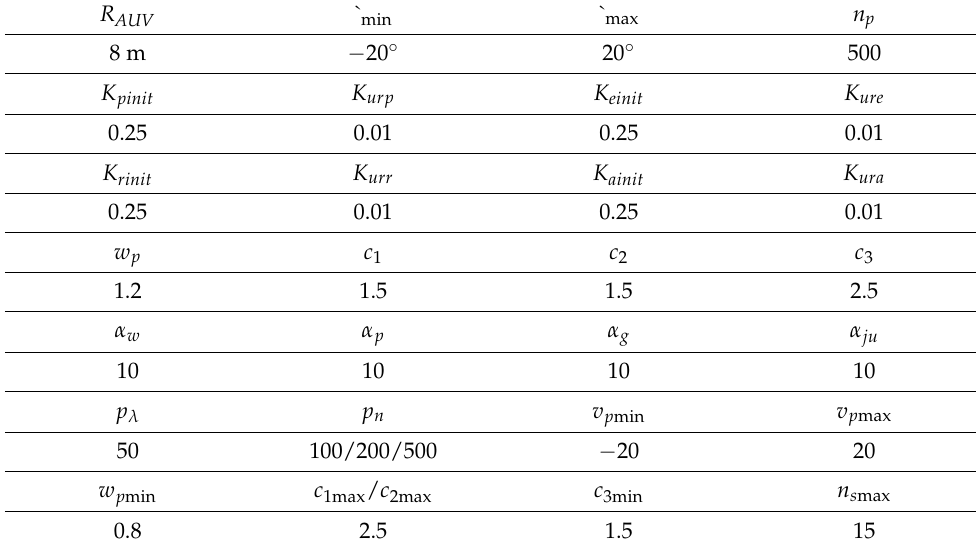
Table 2. Values of the initial Table 1. Values of the initial parameters.